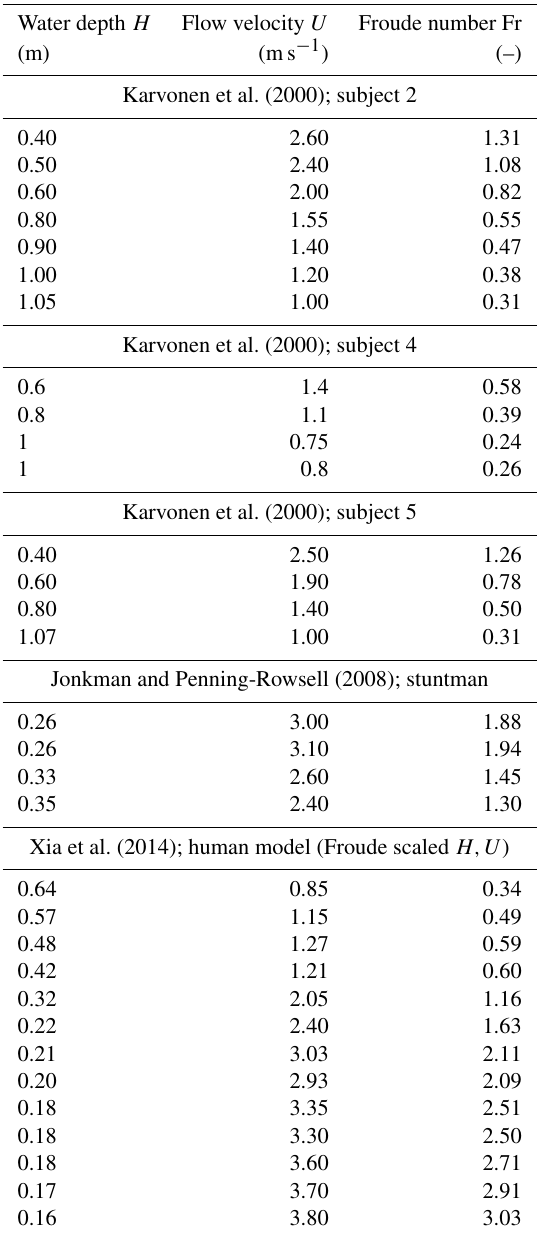
Table 2. Simulated pairs of water depth H and flow velocity U for human subjects and scale model (Karvonen et al., 2000; Jonkman and Penning-Rowsell, 2008; Xia et al., 2014).